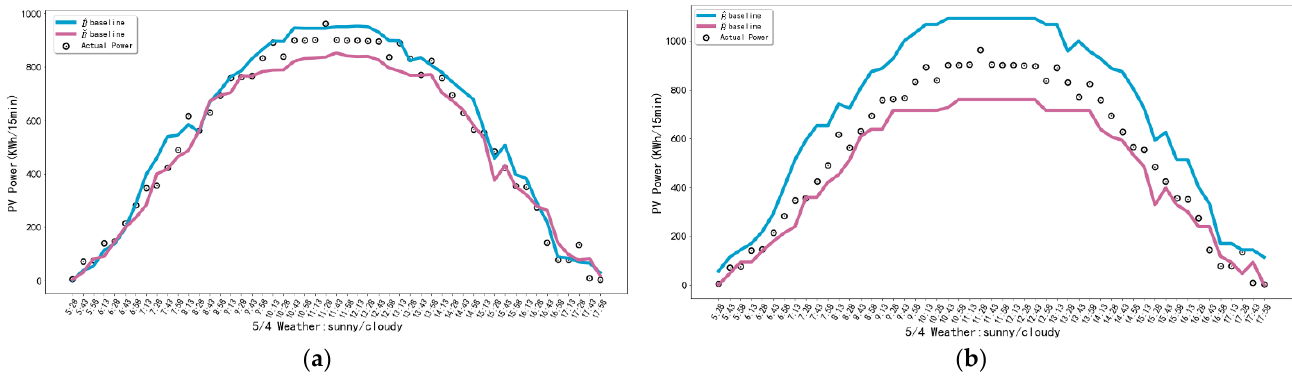
Figure 5. ( a ) Baselines and actual power data of a day in May; ( b ) Modified baselines and actual power data.